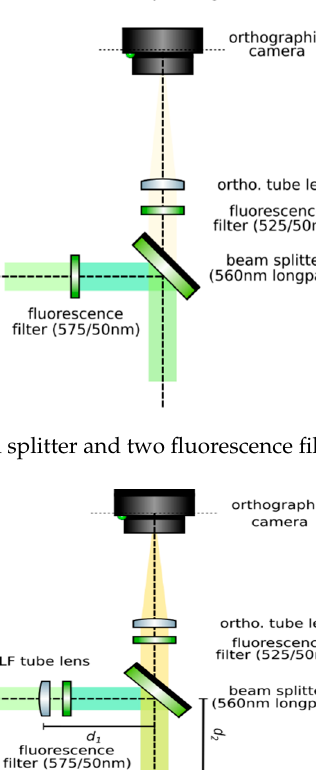
Figure 10. Place a detection objective.